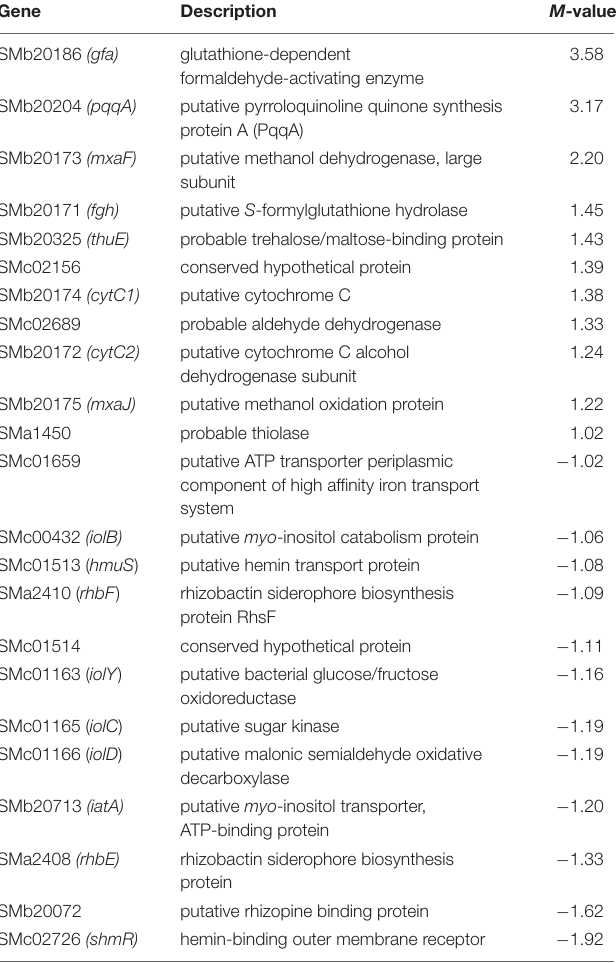
TABLE 2 | Partial list of S. meliloti genes differently expressed in the phosphatidylethanolamine-deficient mutant CS111 (M > 1 or M < −